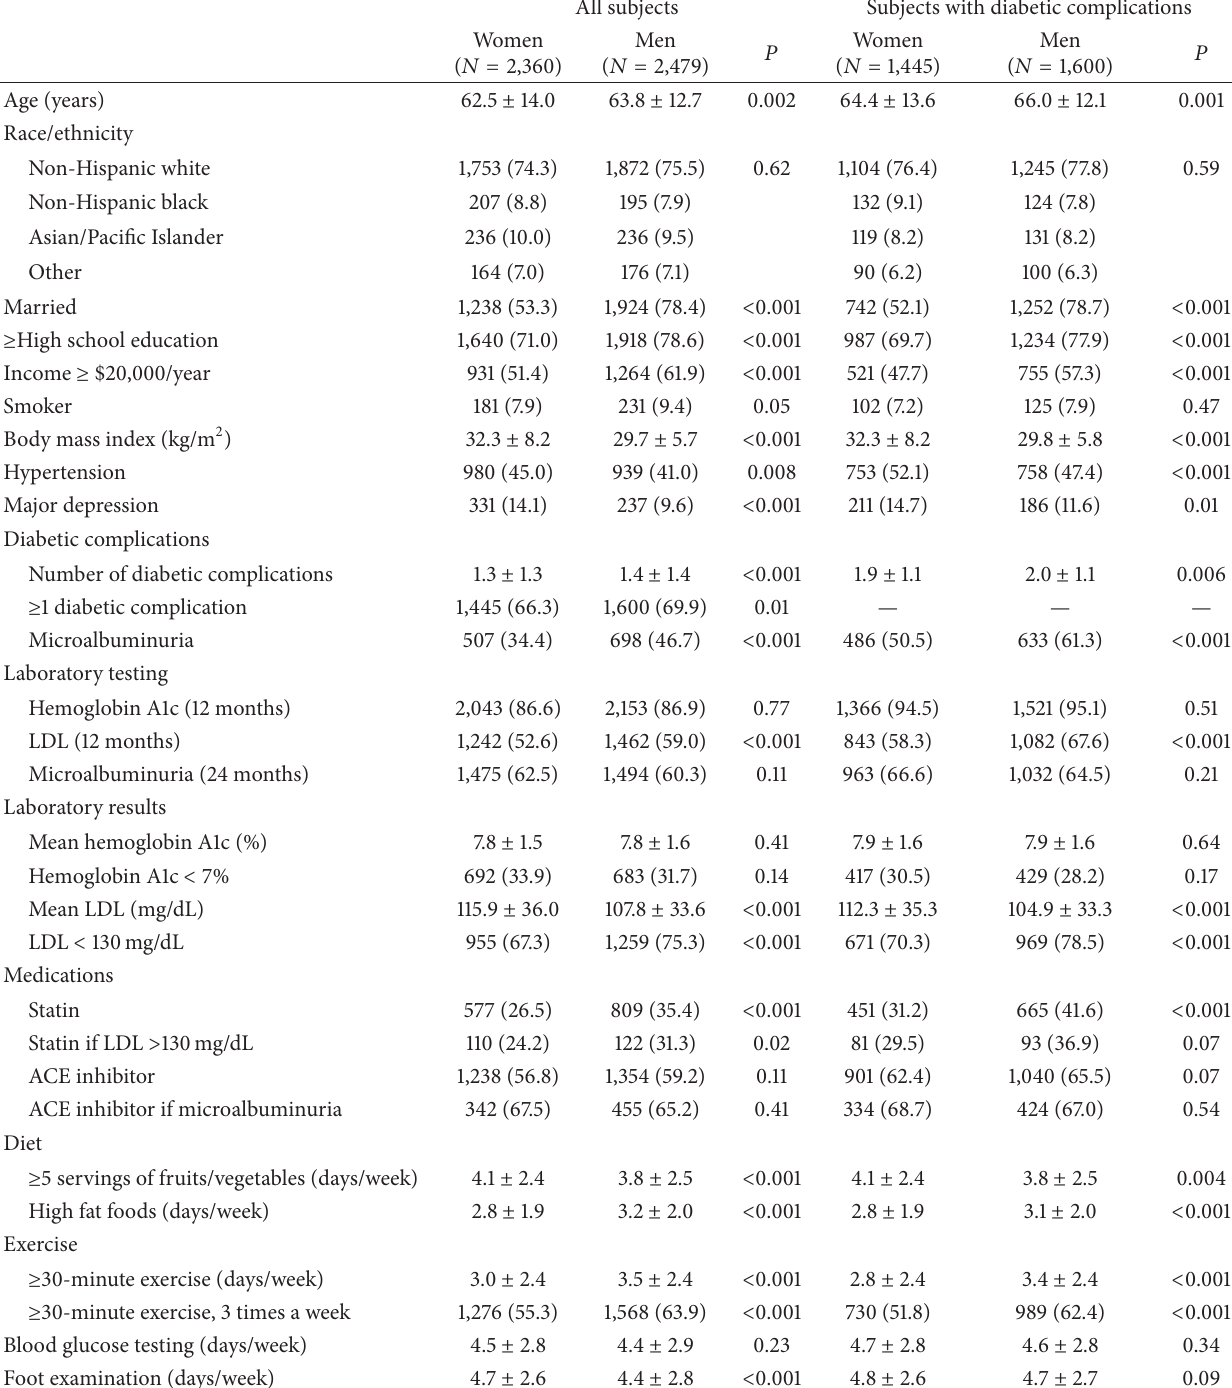
Table 2: Pathways cohort characteristics by